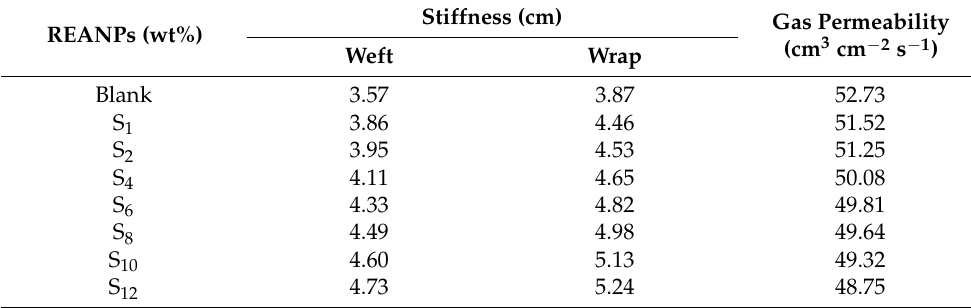
Table 4. Effect of pigment content on stiffness and gas permeability of spray-coated cotton textiles.